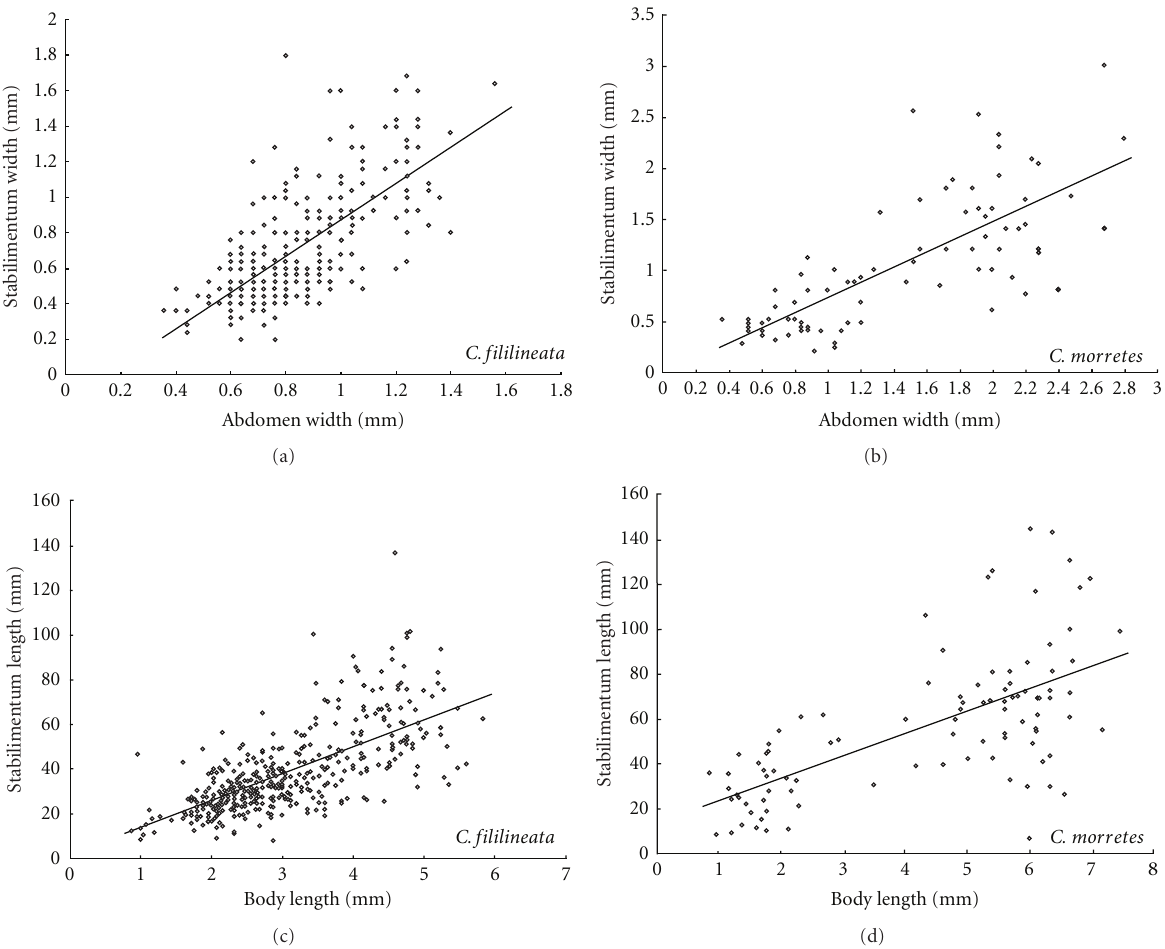
Figure 3: Relationship between abdominal width and the width of the linear detritus stabilimenta constructed by (a) C. fililineata and (b) C. morretes; and between body length and the length of the linear detritus stabilimenta constructed by (c) C. fililineata and (d) C. morretes . The points represent the pooled results for adults and juveniles from all